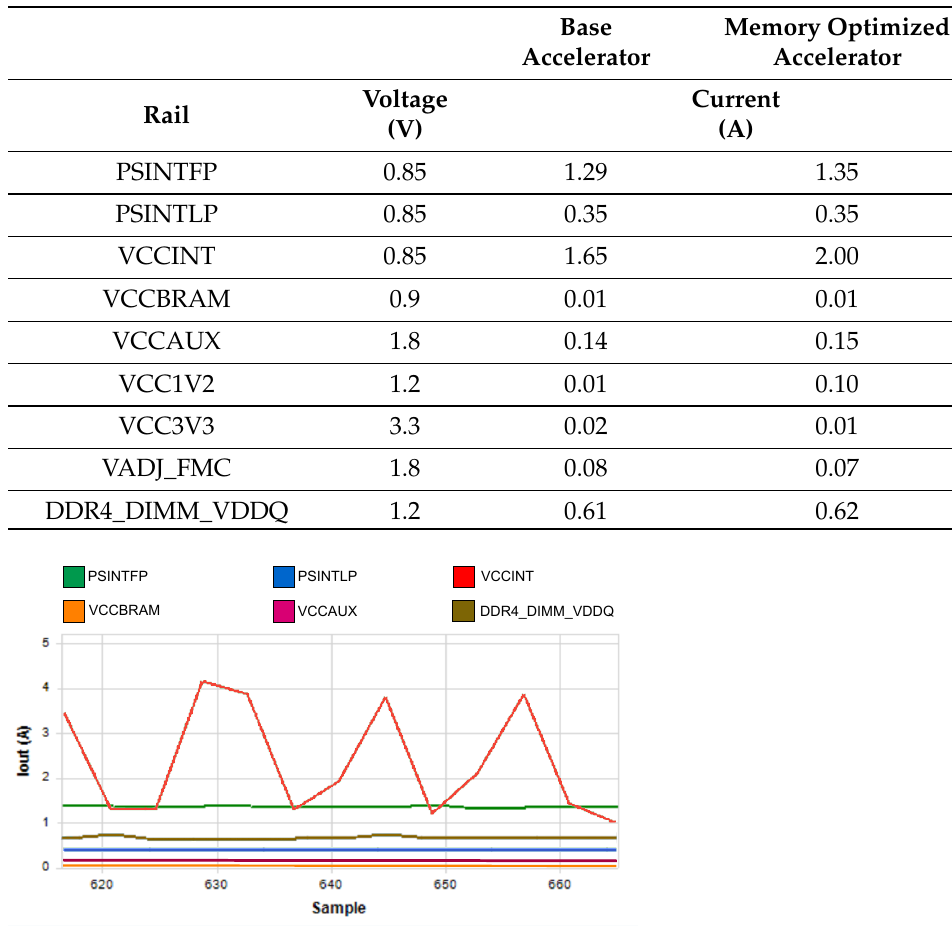
Figure 6. Current trends in the Memory Optimized Accelerator.